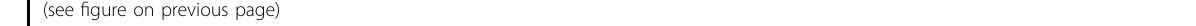
Fig. 3 ESR1 activates AKT signaling in human muscle stem/progenitor cells. a Representative immunoblotting of phosphorylated AKT, total AKT, phosphorylated CREB, total CREB, and GAPDH of human muscle stem/progenitor cells with different treatments. Upon initiation of differentiation, DMSO, estradiol, ESR1 agonist PPT, or ESR1 antagonist MPP was added in culture, respectively. Cells were treated for 2 h and harvested for analysis. Total proteins were extracted and subjected for immunoblotting. The quanti fi cation of the band intensity was listed below each band. b Representative immuno fl uorescent staining of MyHC with differentiated human muscle stem/progenitor cells. Human muscle stem/progenitor cells were differentiated for 6 days and treated with DMSO, PPT, SC79, AKTi-1/2, 666-15, PPT combined with AKTi-1/2, and PPT combined with 666-15, respectively. PPT, ESR1 agonist; MPP, ESR1 antagonist; SC79, AKT signaling agonist; AKTi-1/2, AKT signaling inhibitor; 666-15, CREB inhibitor. Red indicated MyHC; blue indicated DAPI staining of nuclei. The merged images were shown. Scale bars: 100 μ m. c Statistical analysis of the average diameter of myotubes by small molecule treatment. Error bars indicated standard deviation ( n = 5). ** P < 0.01; *** P < 0.001. d Statistical analysis of the differentiation ef fi ciency. Error bars indicated standard deviation ( n = 5). * P < 0.05; *** P < 0.001. e Expression levels of MYH1 , MYH3 , and CKM . Human muscle stem/progenitor cells were induced to differentiate for 6 days while treating with various types of small molecules targeting ESR1-AKT-CREB signaling. Total RNA was extracted from each sample and subjected for RT-qPCR analysis. Error bars indicated standard deviation ( n = 3). ** P < 0.01; *** P < 0.001. f The scheme of luciferase construct. The red triangles indicated predicted CREB binding site (cAMP response element). TSS indicated the transcription starting site. The potential promoter region of MYH1 ( – 1958 bp to TSS) or MYH3 ( – 1536 bp to TSS) was cloned into the MYH - Luciferase plasmid. g Expression of ectopic CREB and phosphorylated CREB in luciferase assays. The 293T cells were transfected by plasmid encoding CREB and harvested 2 days after transfection. Total proteins were extracted and subjected for immunoblotting of CREB and phosphorylated CREB. GAPDH served as the internal control. h Statistical analysis of luciferase essays. Error bars indicated standard deviation ( n = 3). *** P < 0.001. i ESR1 signaling regulated muscle stem cell differentiation. PPT, ESR1 agonist; SC79, AKT signaling agonist; AKTi-1/2, AKT signaling inhibitor; 666-15, CREB